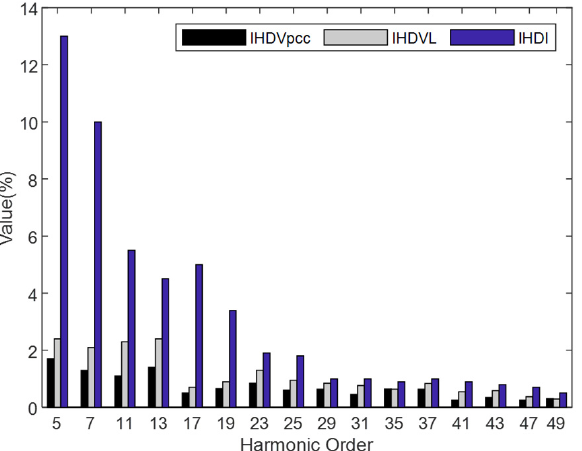
Figure 9. The individual harmonic voltage and current distortion values—scenario 2. Table 6. Comparison of the POF and the represented OF in [29], based on the AOA.